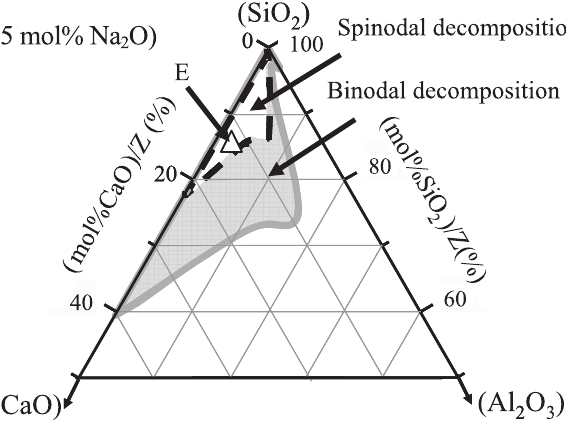
Fig. 4: Calculated composition ranges for spinodal and binodal